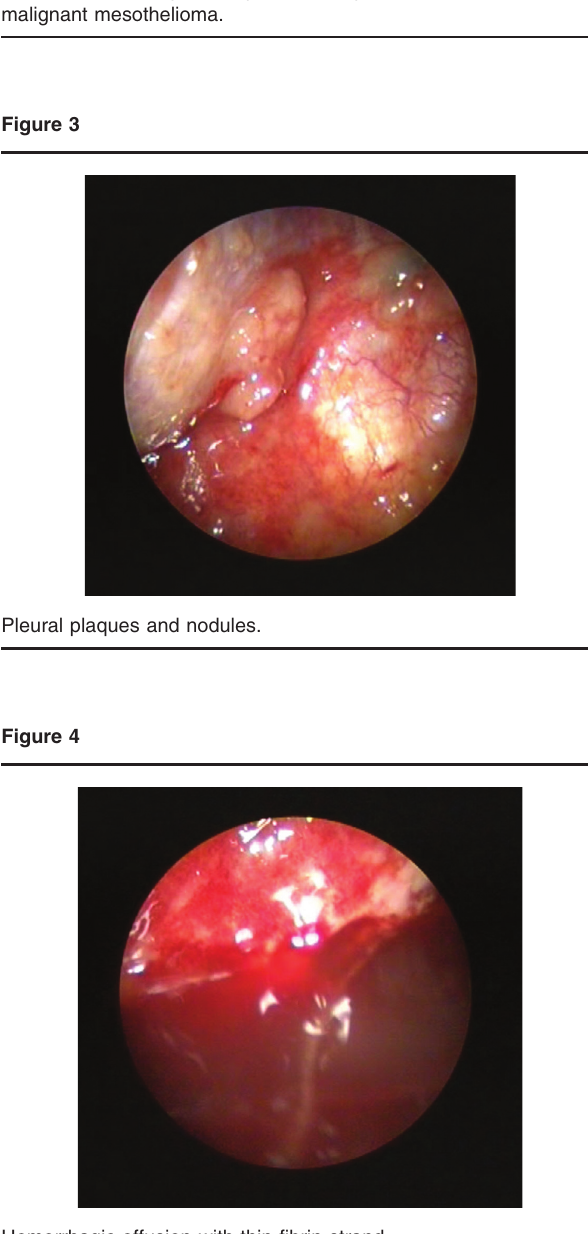
Hemorrhagic effusion with thin fibrin